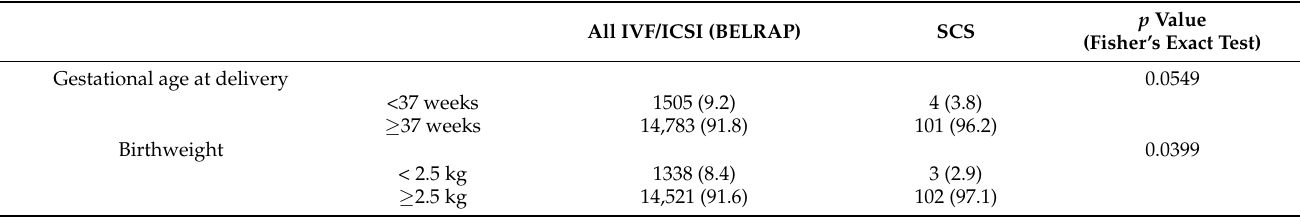
Table 1. Preterm birth and low birthweight comparison between SCS and all IVF/ICSI BELRAP singletons, after fresh embryo transfer—number